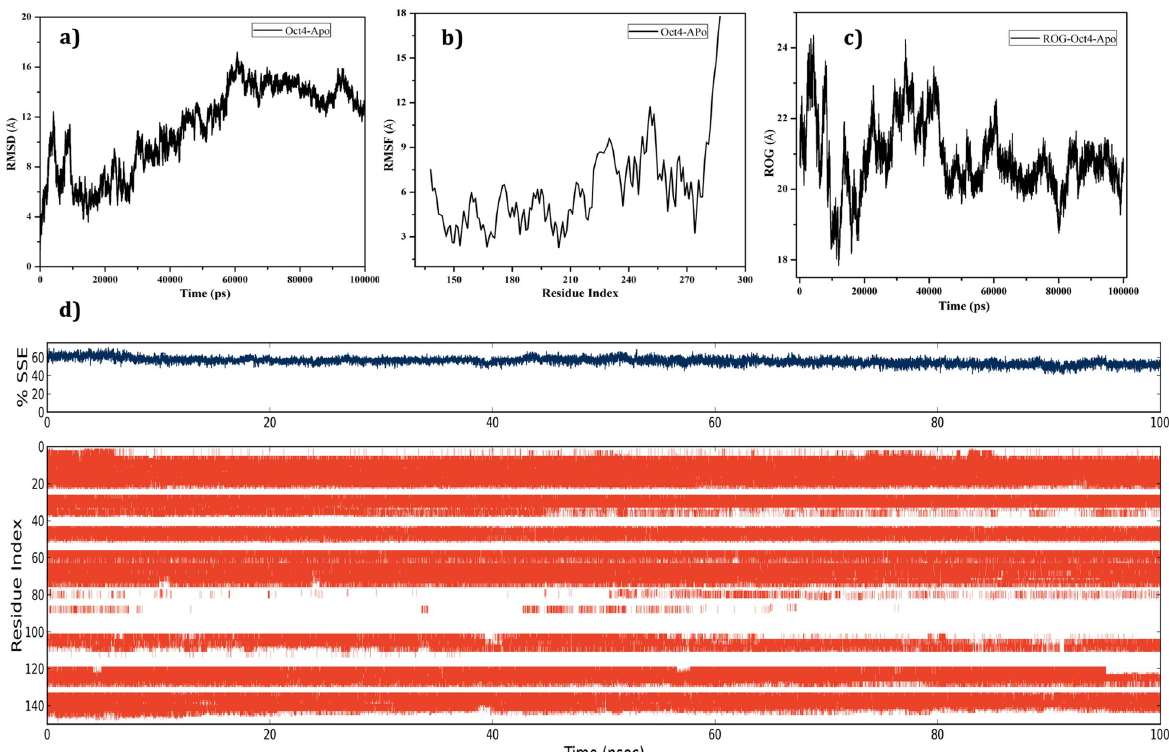
Fig 4. Stability evaluation results of predicted 3D coordination of Oct4 through molecular dynamics simulation. a) Backbone RMSD; b) C- alpha RMSF of Oct4; c) ROG for Oct4; d) SSE percentage and its occupancy of helices (orange), strands, turns and loops (white) over 100ns time period with reference to the index of the